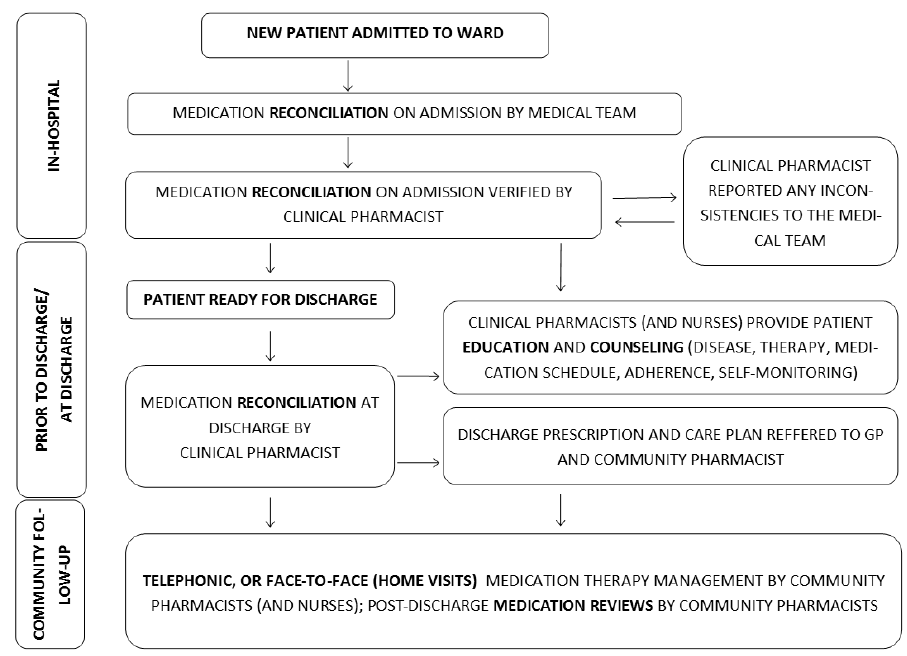
Figure 6. A flow chart describing process of comprehensive care and role of clinical and community